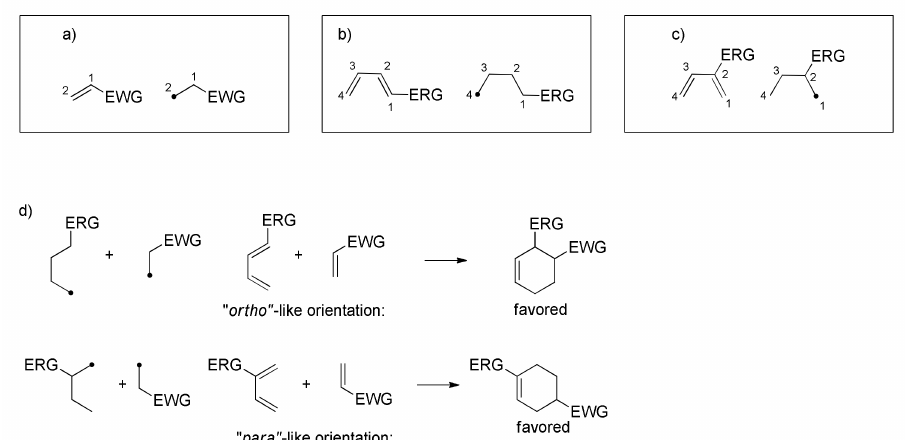
Figure 4. Regioselectivity of DA reactions according to FMO theory: ( a ) the carbon bonded to EWG on the dienophile has a higher coefficient than the other carbon; ( b ) the carbon C-1 directly bonded to ERG on the diene has a higher coefficient than others; ( c ) the carbon C-1, adjacent to the carbon bonded to ERG, has a higher coefficient than others; ( d ) “frontier” carbons with a higher coefficient match in the forming cyclohexene ring.